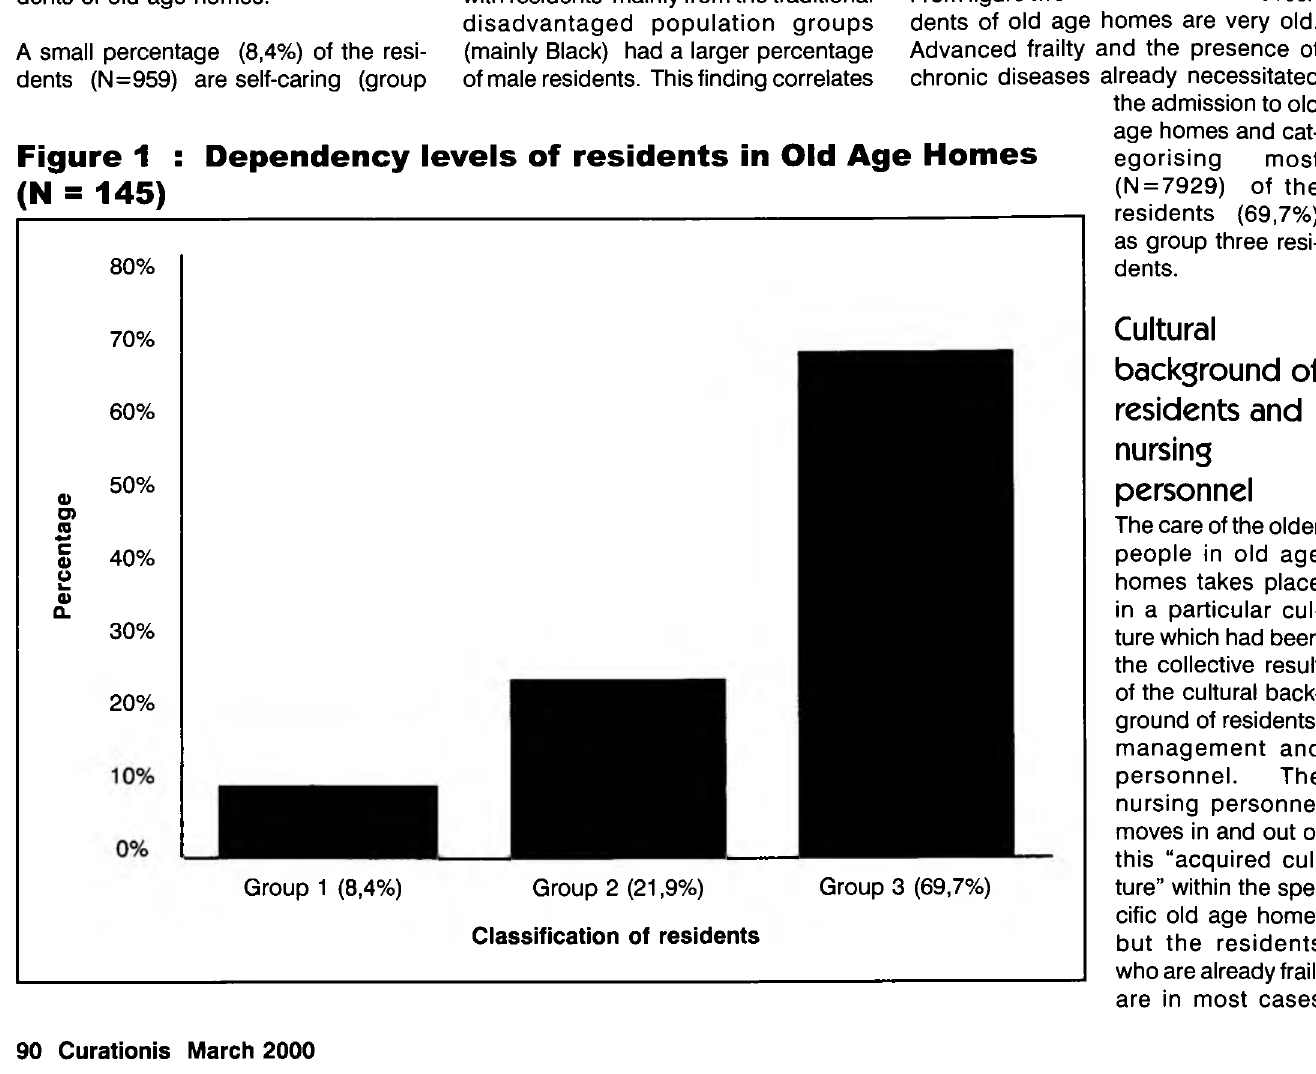
Figure 1 : Dependency levels of residents in Old Age